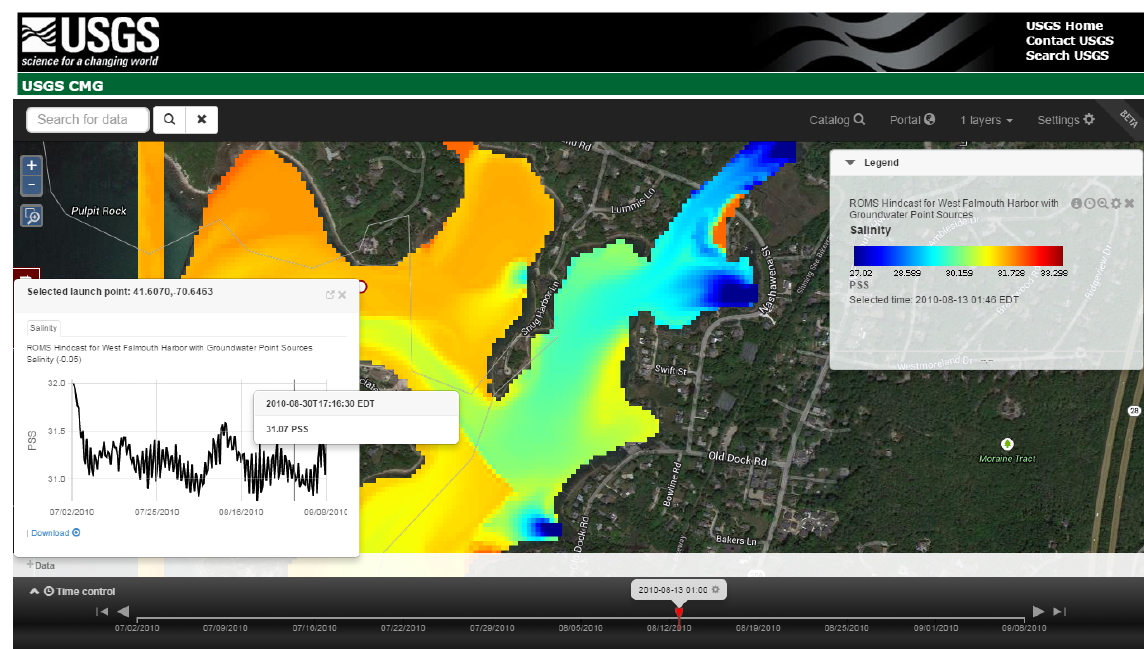
Figure 9. Viewing a USGS CMG data set in the CMG_Portal web application. The map is made by a dynamic request to the WMS service provided by the THREDDS Data Server. The user has clicked a location on the map, which extracts a time series at that location using the WMS getFeatureInfo response.